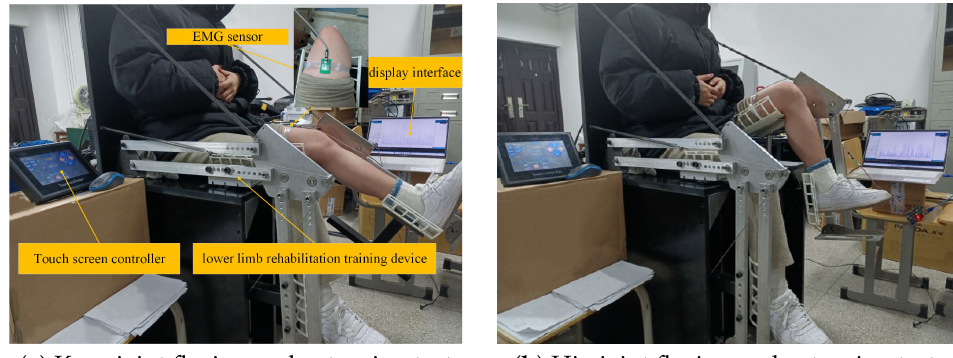
Figure 13. Schematic diagram of the control process.